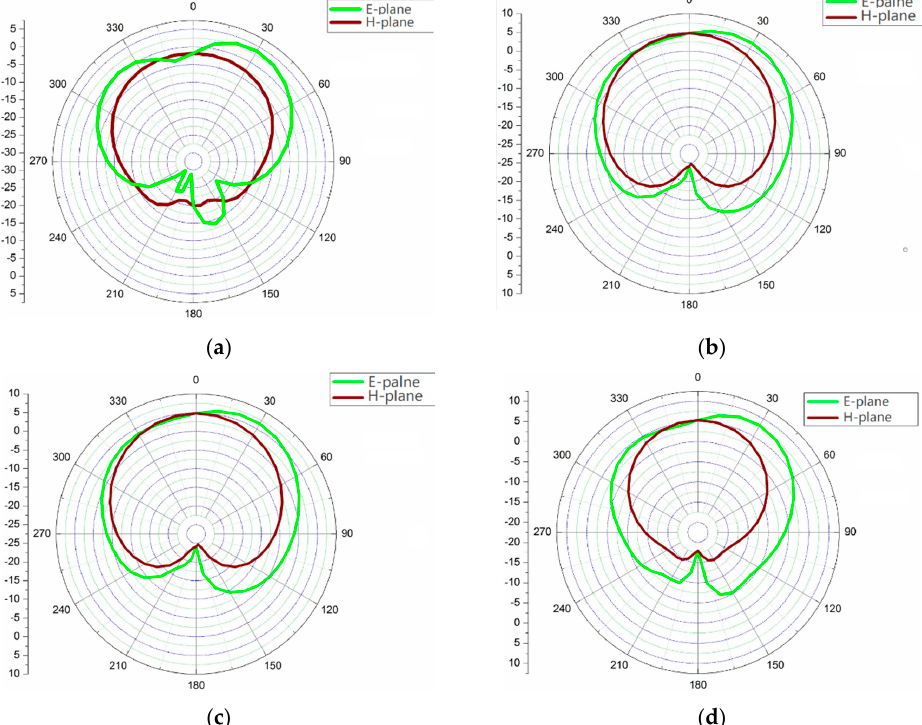
Figure 8. ( a – d ) Simulated radiation patterns at 5.3 GHz.